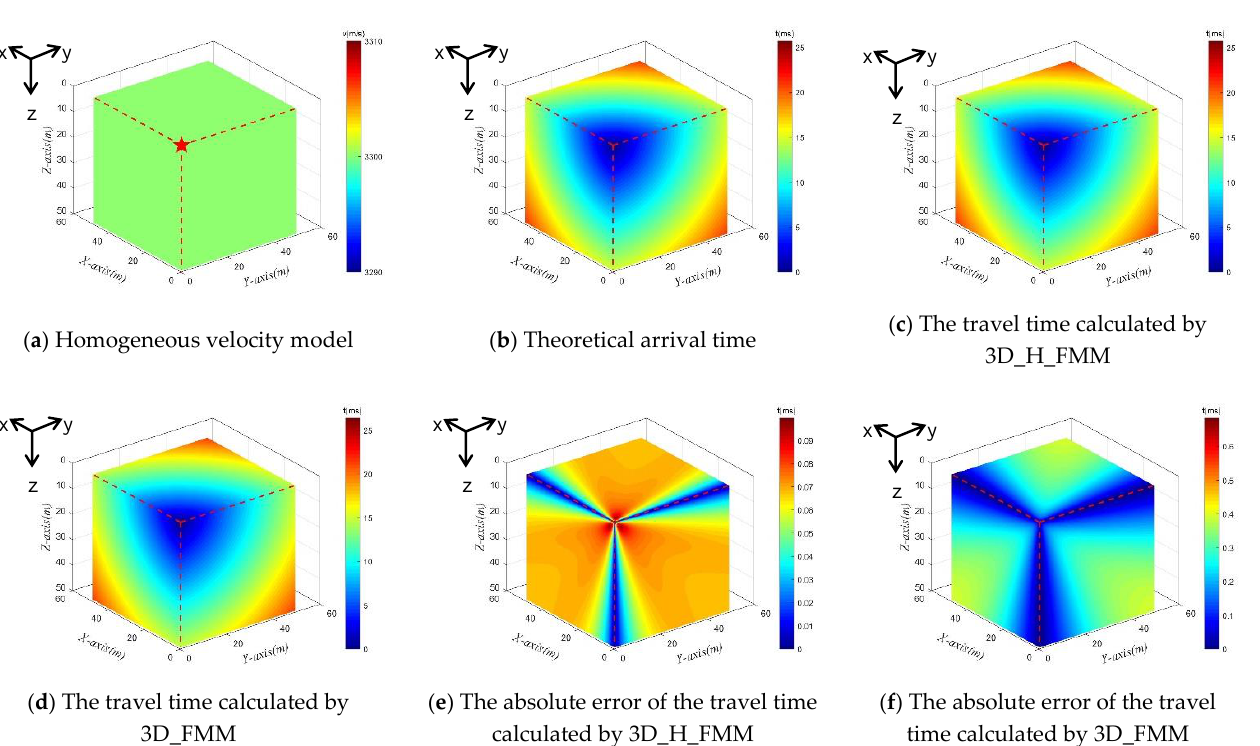
Figure 4. The Case A: small-scaled homogeneous model and its theoretical arrival time, the P-wave travel time and error distribution map calculated by 3D_H_FMM and 3D_FMM.